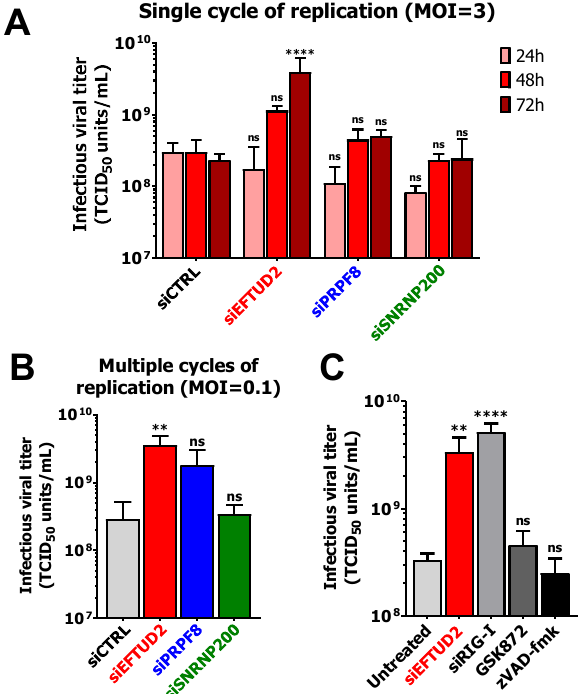
Figure 6. EFTUD2 restricts MRV’s replication in both single cycle and multiple cycles of replication. ( A ) MRV viral titers from siCTRL, siEFTUD2, siPRPF8, and siSNRNP200-treated L929 cells infected cells at 24 h, 48 h, and 72 h. Cells were infected at a MOI of 3, and viral titers were determined by TCID 50 on L929 cells. n = 3, biological replicates, two-way ANOVA with Dunnett’s multiple comparisons test against the siCTRL matched timepoint (ns, p > 0.05; ****, p ≤ 0.0001). ( B ) MRV viral titers from siCTRL, siEFTUD2, siPRPF8 and siSNRNP200-treated L929 cells infected cells at 96 h. Cells were infected at a MOI of 0.1, and viral titers were determined by TCID 50 on L929 cells. n = 3, biological replicates, one-way ANOVA with Dunnett’s multiple comparisons test against the siCTRL condition (ns, p > 0.05; **, p ≤ 0.01). ( C ) MRV viral titers in L929 cells untreated,